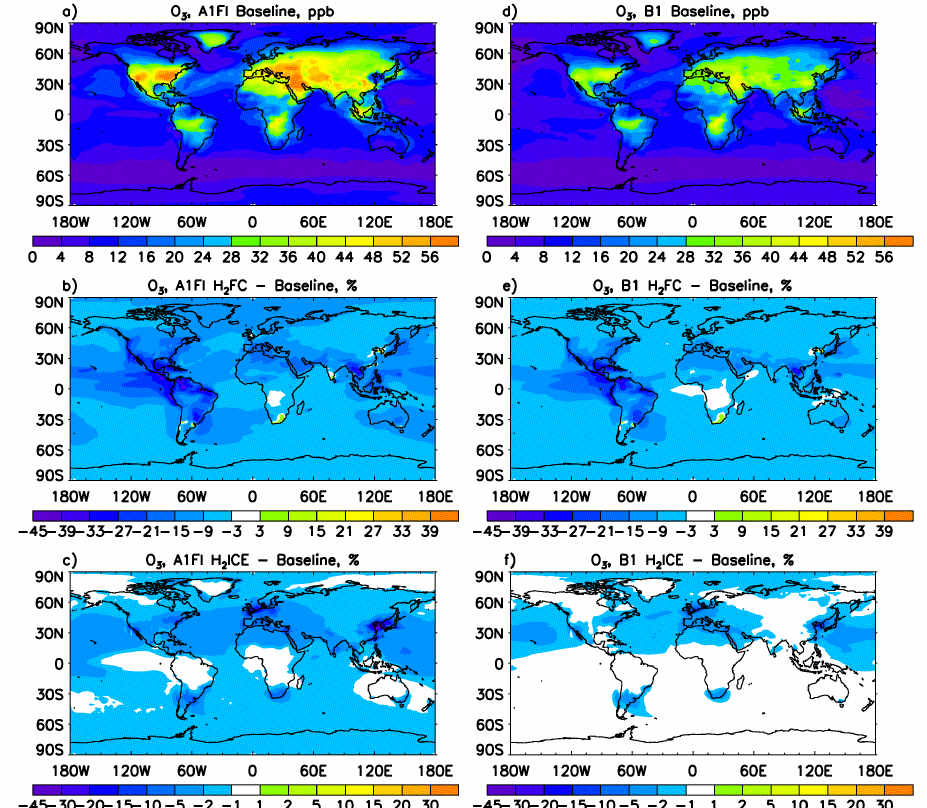
Figure 3. CAM-Chem simulated 2050 NH summer (June, July, and August) average ground-2 Fig. 3. CAM-Chem simulated 2050 NH summer (June, July, and August) average ground-level O 3 mixing ratios in the A1FI (a) and B1 (d) baseline scenarios and percent differences for the H 2 fuel cell (H 2 -FC) and H 2 internal combustion engine (H 2 -ICE) scenarios (b, c, e, f) . level O 3 mixing ratios in the A1FI (a) and B1 (d) Baseline scenarios and percent differences 3 Note the different for the H 2 Fuel Cell (H 2 -FC) and H 2 Internal Combustion Engine (H 2 -ICE) scenarios (b, c, e 4 and f). Note the different scales. 5